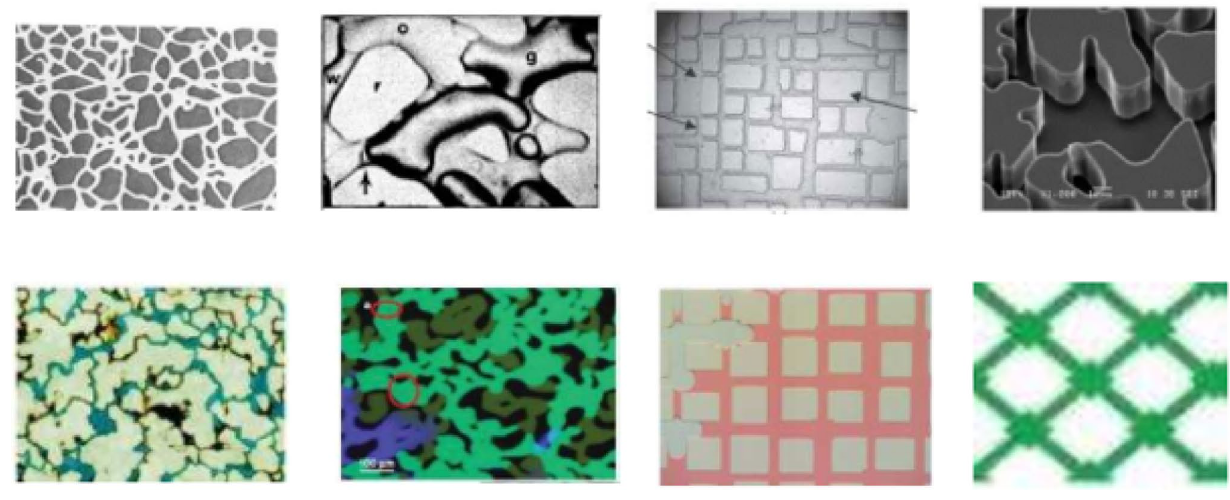
Fig. 1 Micromodel pore patterns